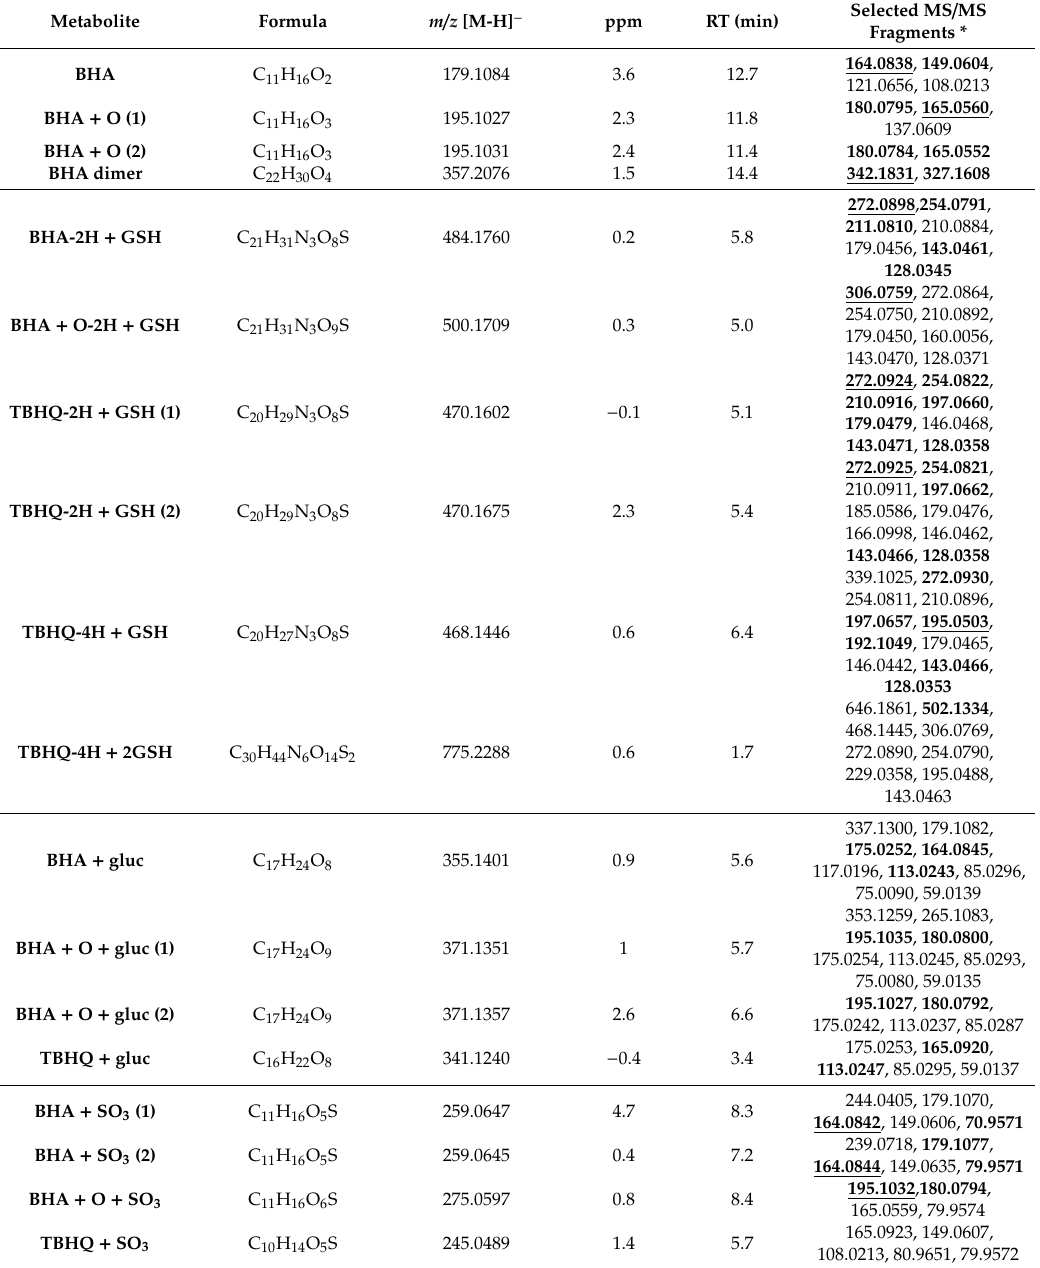
Table 3. Summary of MS / MS data for BHA metabolites in negative ion